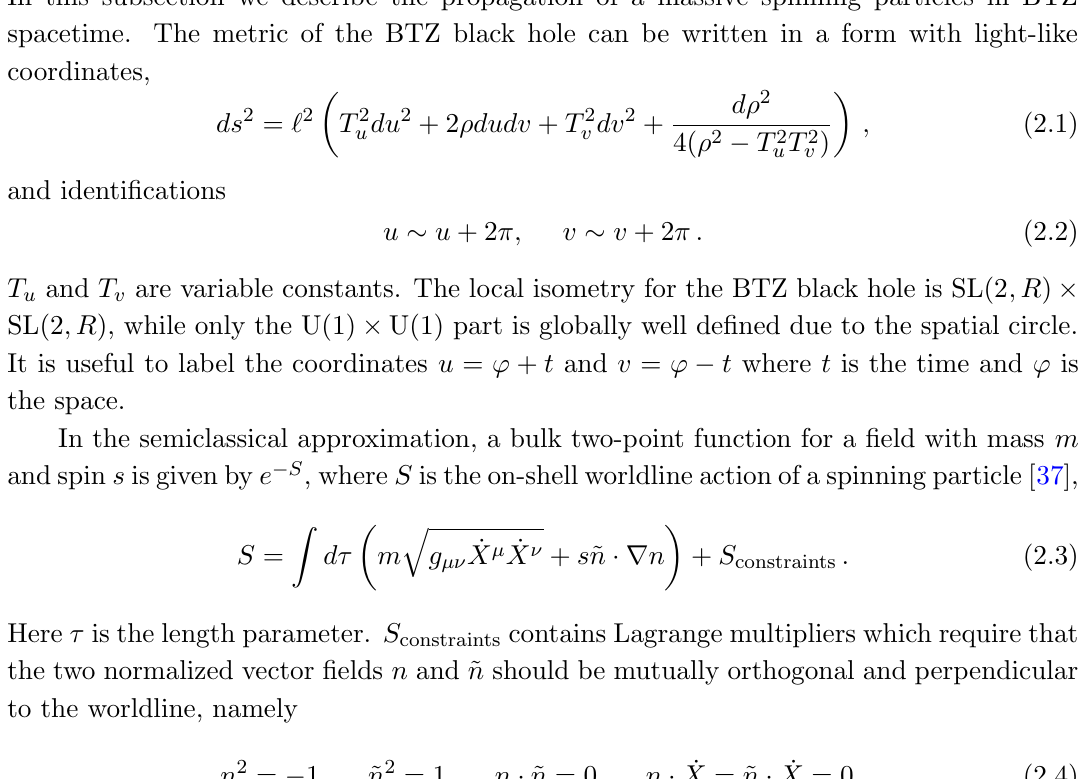
propagates from in(cid:12)nity to horizon, where it splits into O and (cid:30) which wrap the y (cid:31) (cid:31)